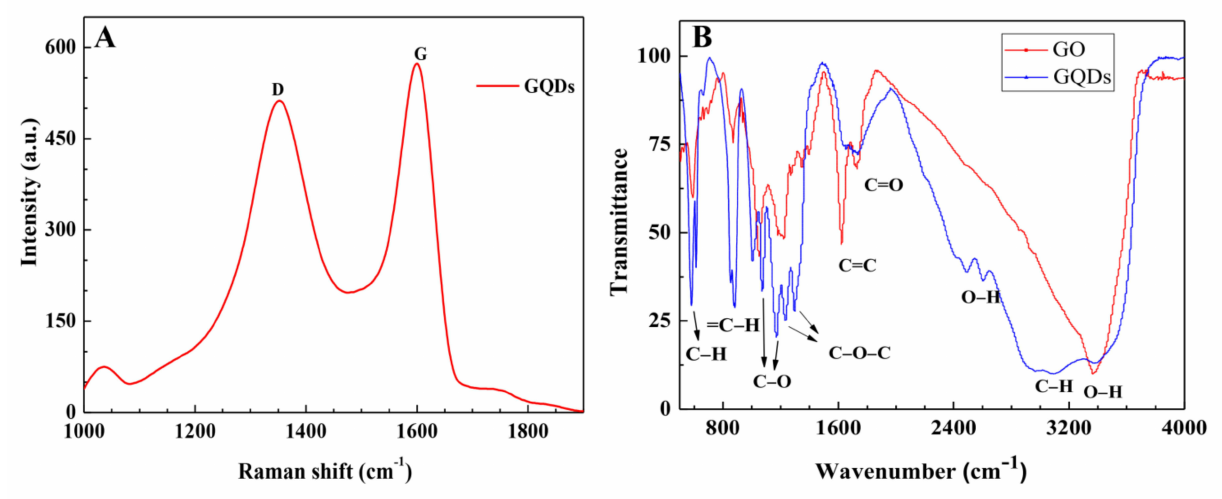
Figure 4. ( A ) Raman and ( B ) FTIR spectra of the GQDs. In ( B ), GO is for comparison.